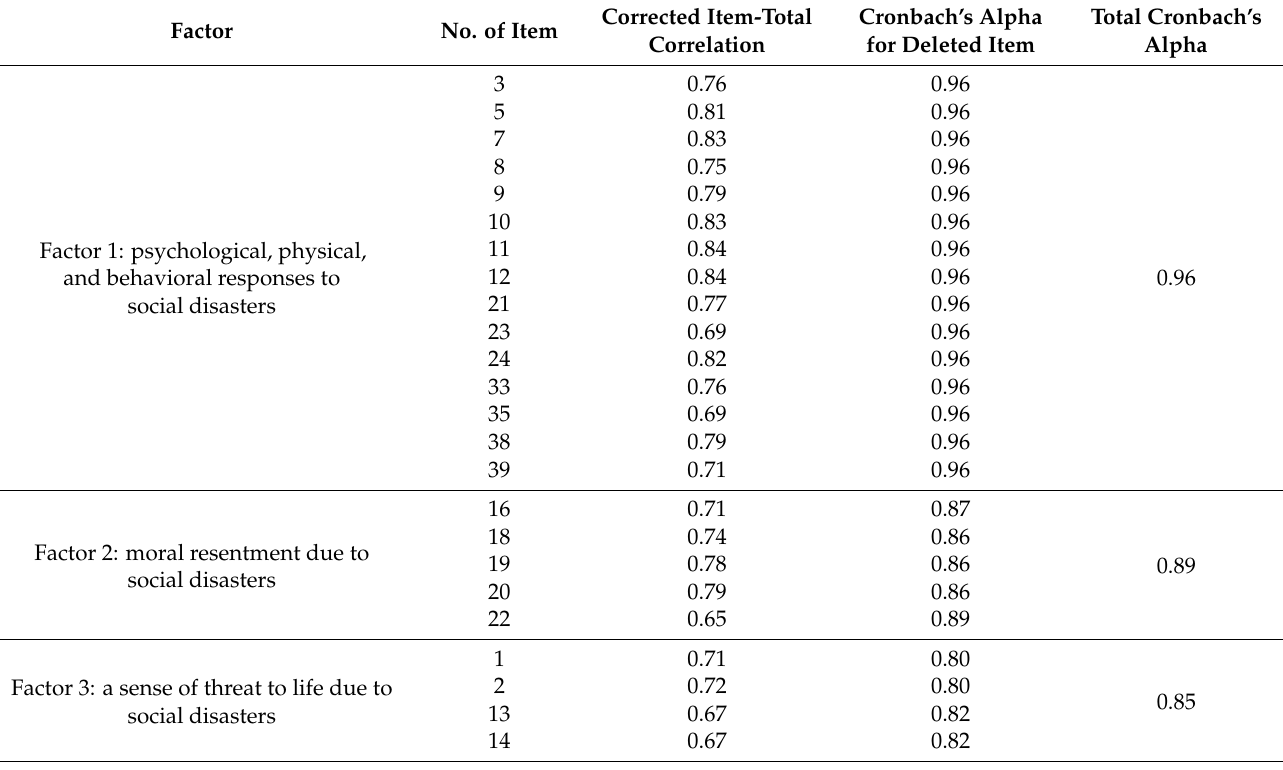
Table 3. The results of reliability test.